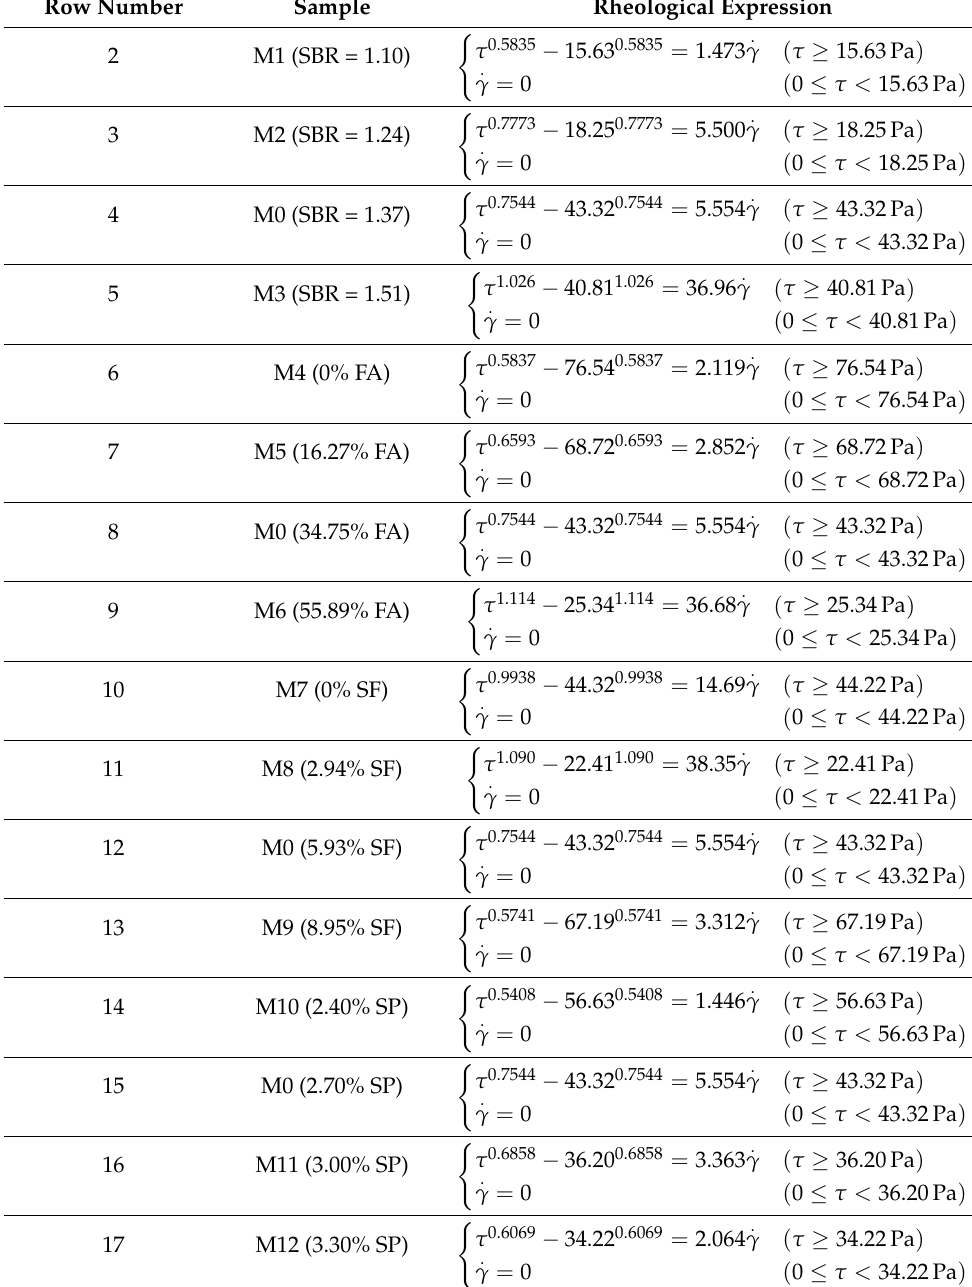
Table 4. Rheological expression of shear stress and shear strain